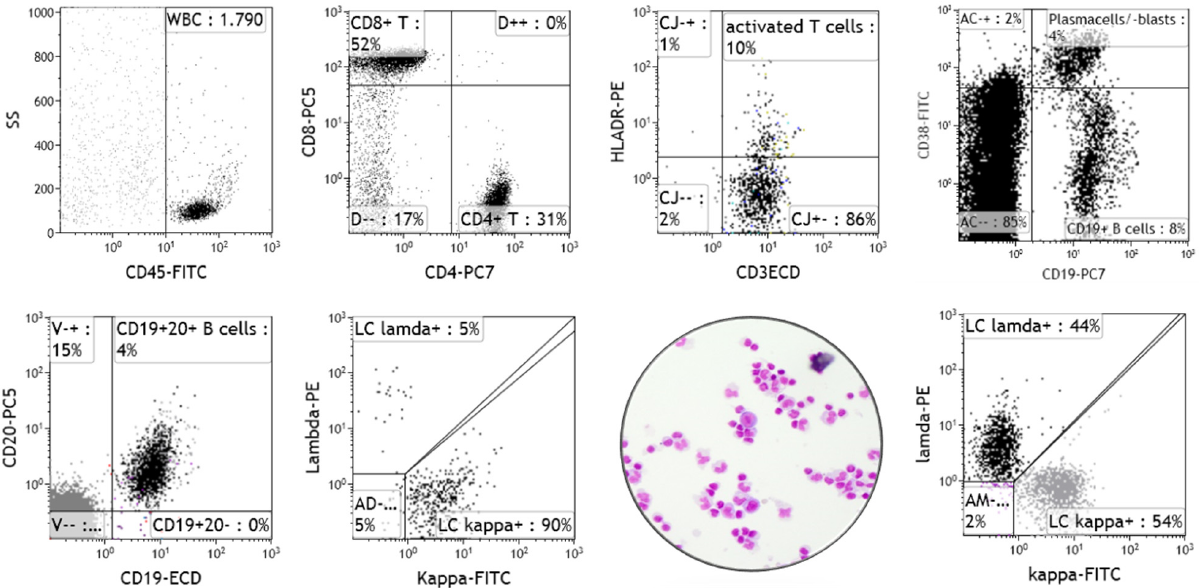
Figure 5. Flow cytometry of CSF cells (own data). Upper panel, from left to right: Shown are repre- sentative flow cytometry plots illustrating CD45+ CSF immune cells (WBC gate), mainly lymphocytes (SSC low , black population), the CD4+ and CD8+ T cell composition for calculating the CD4+/CD8+ T cell ratio, activated CD3+ T cells (upregulation of HLA-DR), and at the far right, CD19+ B cell activation in the form of plasma blasts (CD19 intermediate CD38 bright ). The lower panel illustrates B cell light chain analysis results with the second plot showing kappa light chain clonality (ratio = 18) confirming suspected CNS B cell malignancy versus a normal kappa/lambda light chain distribution (ratio ~1) shown in the plot far right, and an un-ascertainable CSF cytology of suspected B cell lymphoma in between.